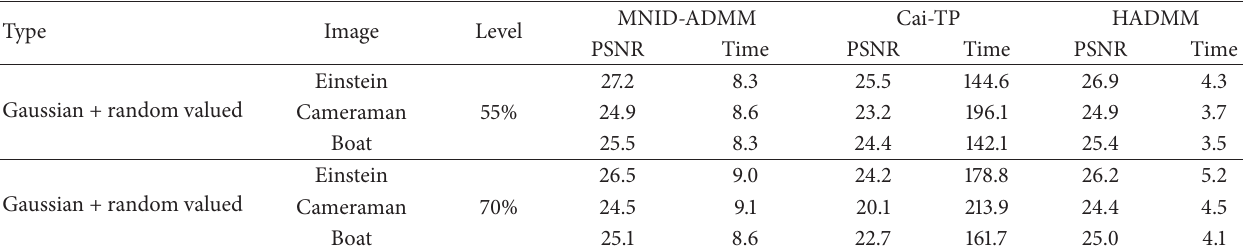
Table 4: The PSNR (dB) and computing time (seconds) for the restoration results by MNID-ADMM, Cai-TP, and HADMM method for blurred images contaminated by random-valued noise plus Gaussian noise ( 𝜎 = 5). The blurring kernel is the out-of-focus kernel of radius 3. Type